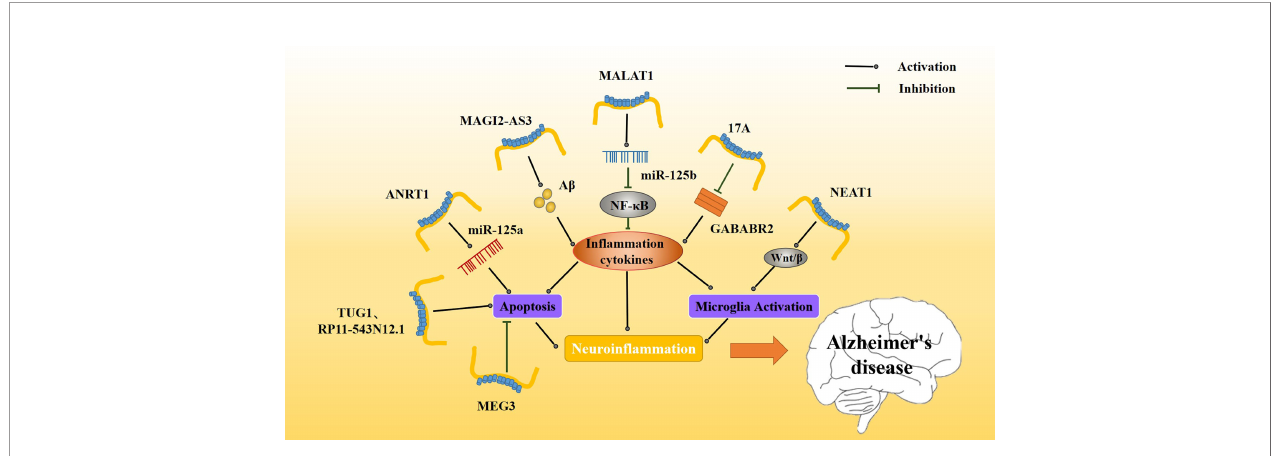
FIGURE 4 | Effect of in fl ammatory lncRNAs on AD in fl ammation. Multiple in fl ammatory lncRNAs may be involved in different in fl ammatory pathways. MAGI2-AS3 promotes the A b -induced in fl ammatory response, whereas MALAT1 regulates release of in fl ammatory cytokines via NF- k B. The release of in fl ammatory mediators further affects the activation and apoptosis of microglia. Together, these constitute a persistent neuroin fl ammatory response that accelerates the progression of